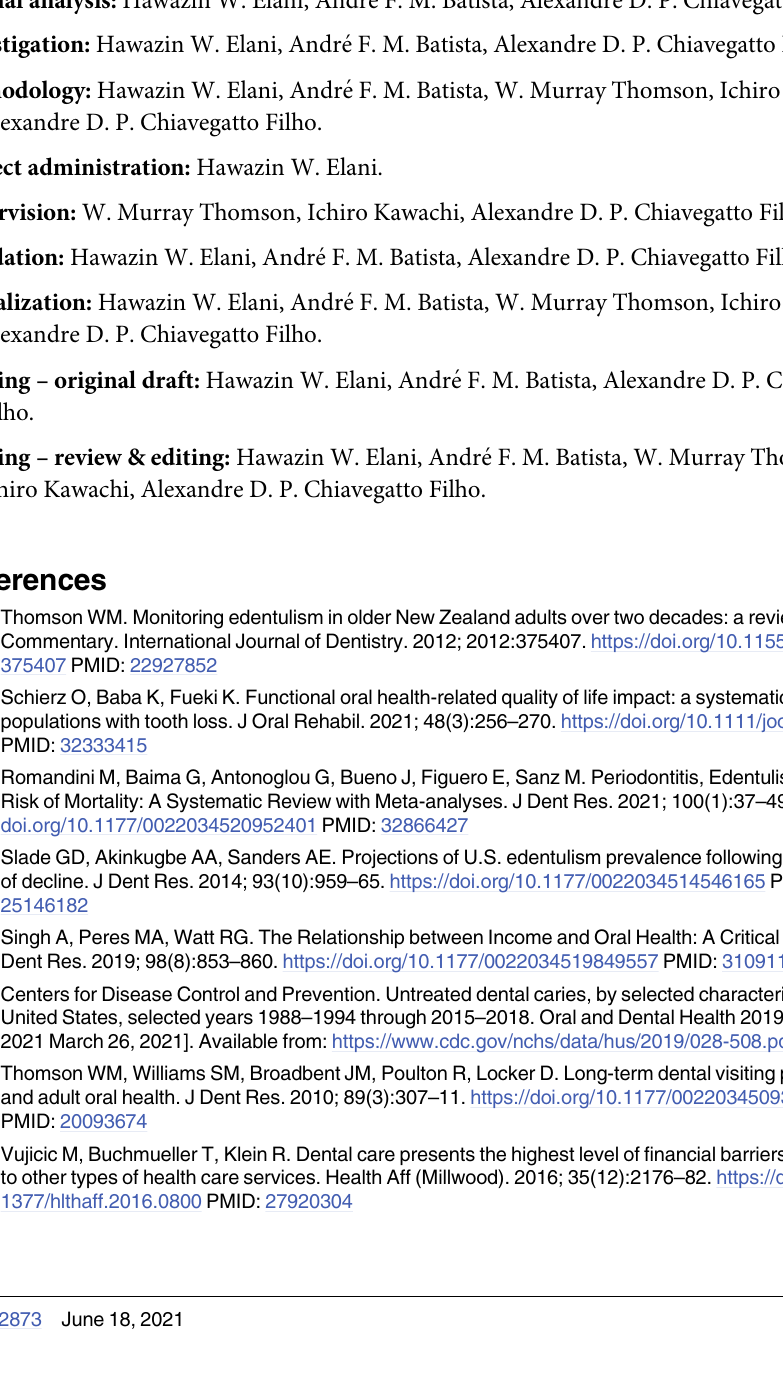
S4 Table. Final hyperparameters for all predictive models for study outcomes. S5 Table. Performance of the machine-learning algorithms on the test data for each study outcome with imputed